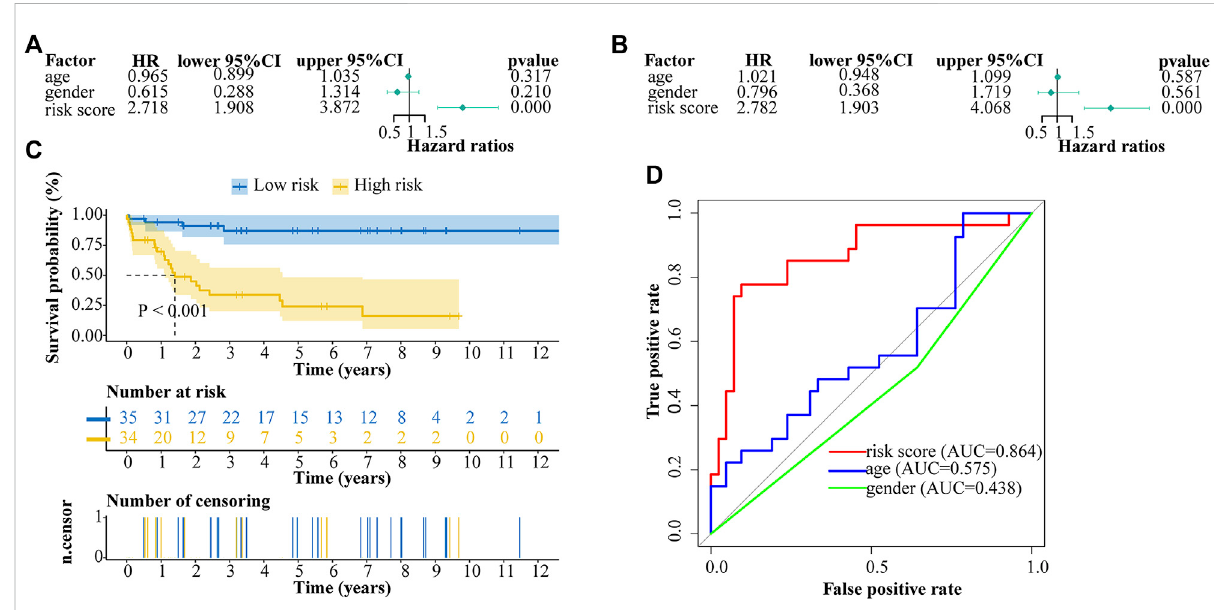
FIGURE 6 Cox proportional hazard regression analysis of ALL risk factors. (A) Univariate cox regression analysis of risk score and other indicators. (B) Multivariatecoxregressionanalysisofriskscoreandotherindicators. (C) Kaplan-MeieranalysisofALLpatientsgroupedaccordingtomedianrisk. (D) Multi-index receiver operating characteristic (ROC) curve of risk score and other